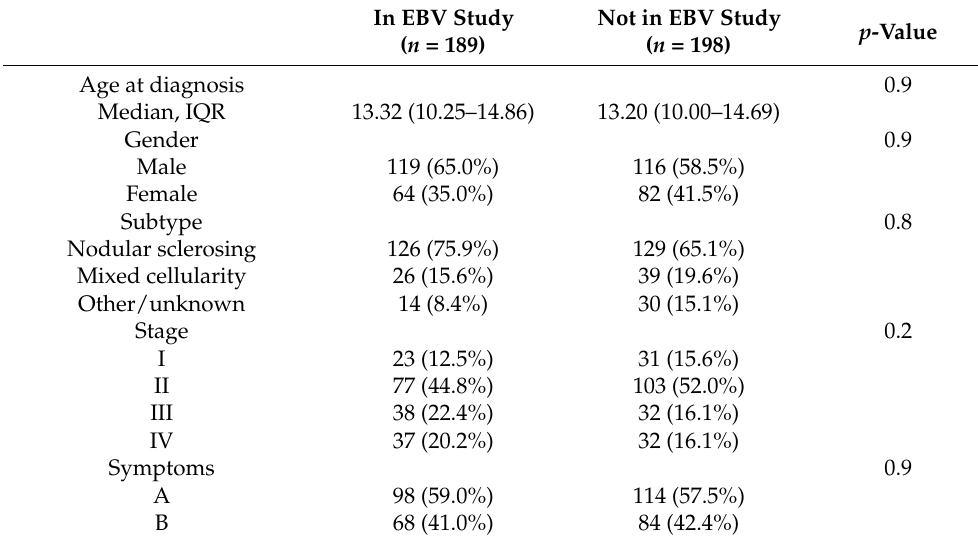
Table 2. Comparison of clinical trial patients included or not included in the EBV study. Interquartile range (IQR).